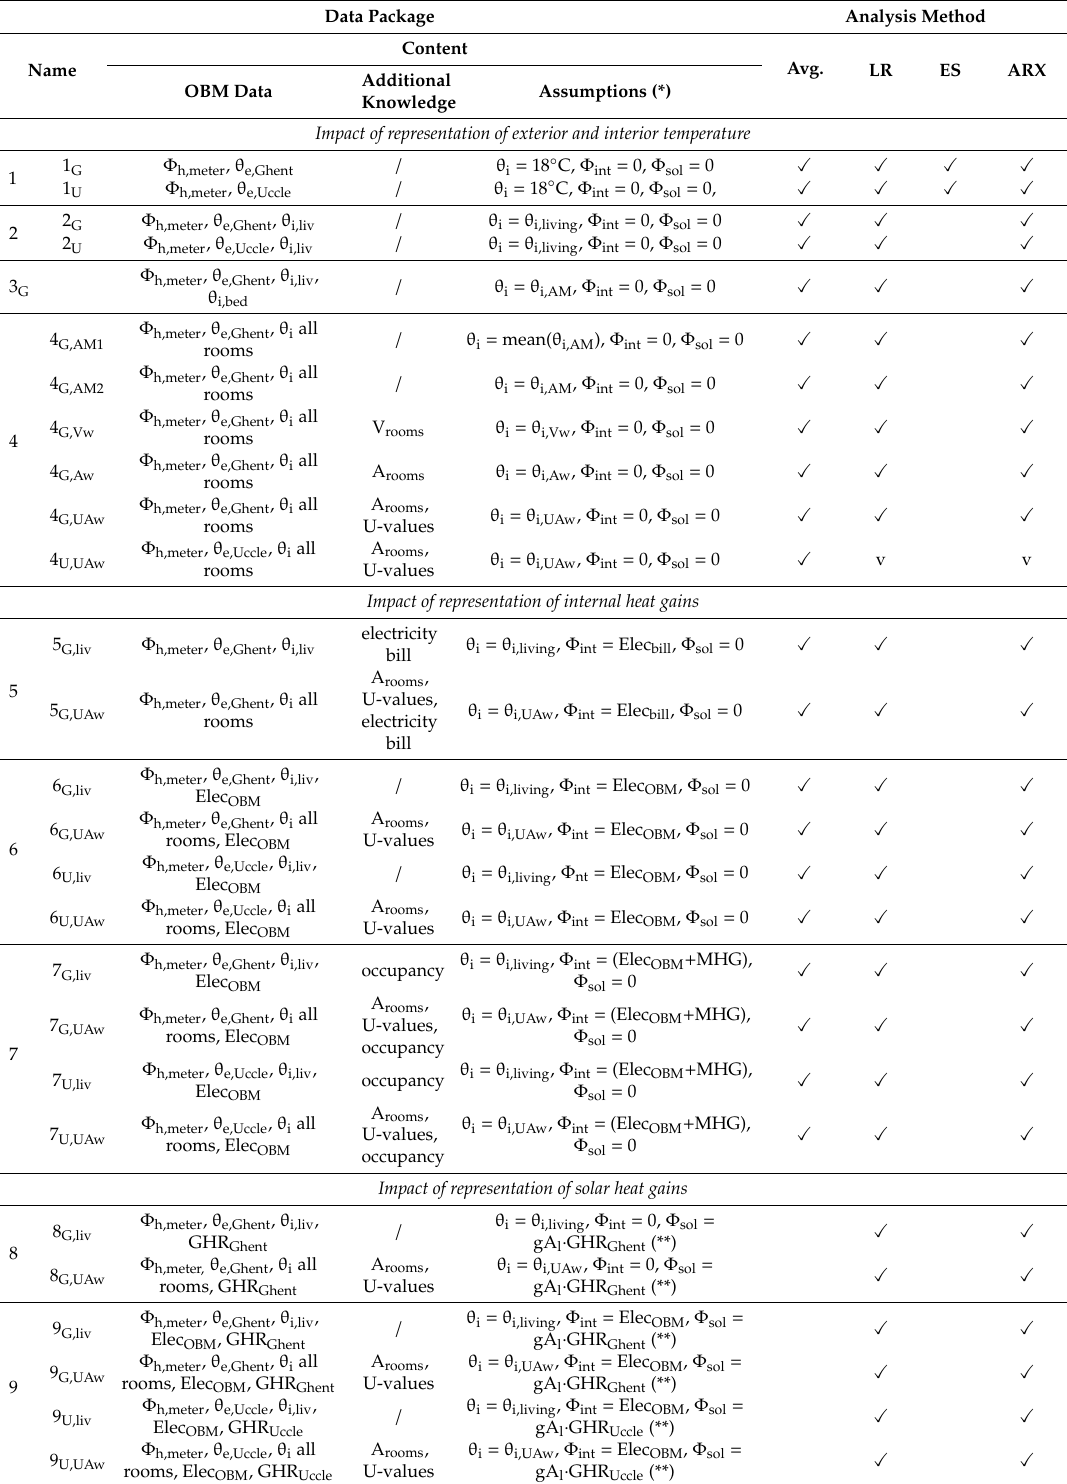
Table 4. Composition of the data packages, and the applied data analysis methods. The abbreviations ‘liv’, ‘bed’, ‘V’, and ‘MHG’ stand for, respectively, ‘living room’, ‘bedroom’, ‘volume’, and ‘metabolic heat